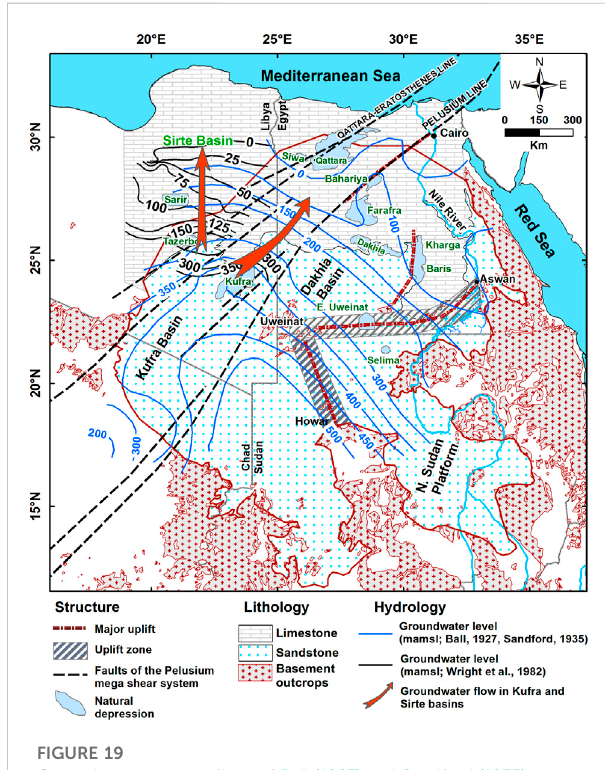
FIGURE 19 Groundwater contour lines of Ball (1927) and Sandford (1935). Also shown is the groundwater level and fl ow direction in the Kufra and Sirte Basins after Wright et al.